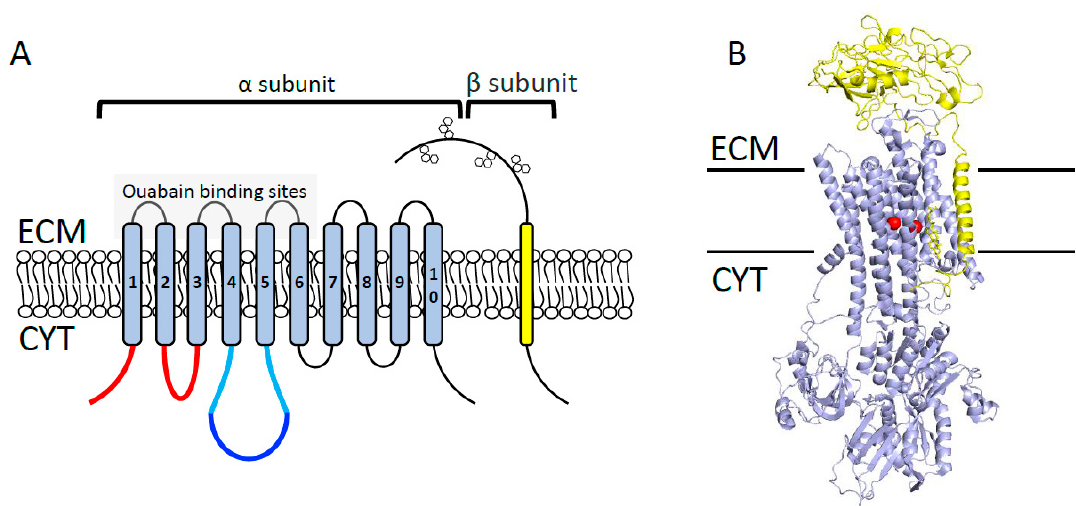
Figure 2. Na + -, K + -ATPase overall structure. ( A ) Na + -, K + -ATPase consists of a catalytic α subunit and a regulatory β subunit. The α subunit consists of 10 transmembrane helices, harboring 3 different cytoplasmic domains: the actuator responsible for dephosphorylation (shown in red); the nucleotide-binding, responsible for ATP binding (shown in blue); and the phosphorylation domains (shown in cyan). The β subunit consists of one transmembrane helix with a large glycosylated extracellular domain (shown in hexagon orange boxes). ECM = extracellular milieu; CYT = cytoplasm. ( B ) Overall domain architecture of Na + /K + transporter in the Na + -bound state (Protein Data Bank [PDB] code 4HQJ). Catalytic α subunit is colored in blue, β subunit is shown in yellow, and Na + ions are shown in red.